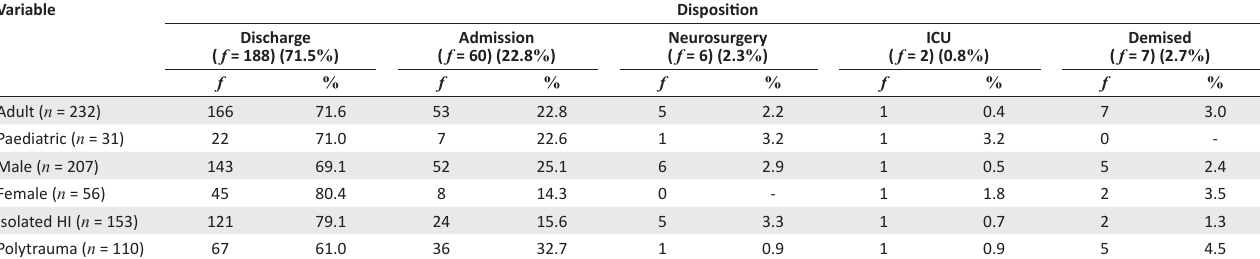
TABLE 4: Disposition from emergency department ( n = 263). Variable Disposition Discharge Admission ( f = 188) (71.5 % ) ( f = 60) (22.8 %